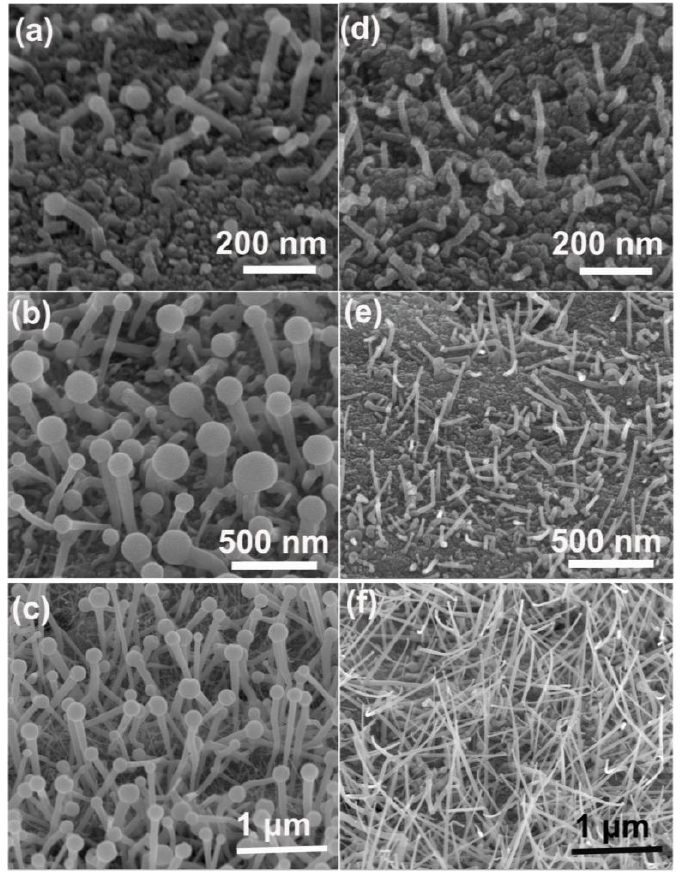
Figure 6. SEM images of the nanowires grown for different time. ( a – c ) The nanowires grown at 440 °C for 5, 20 and 40 min, respectively. ( d – f ) The nanowires grown at 500 °C for 5, 20 and 40 min, respectively.